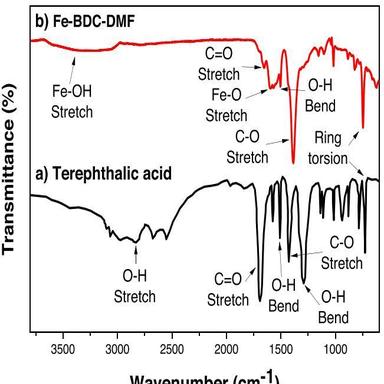
The IR spectra of (a) terephthalic acid (H2BDC) black line and (b) Fe-BDC-DMF red line.